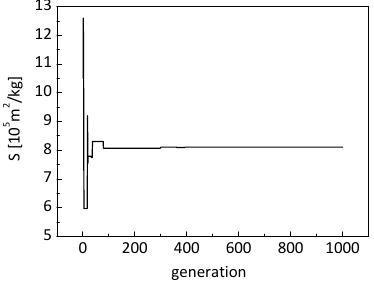
Figure 12. Evolution of the identified specific area.